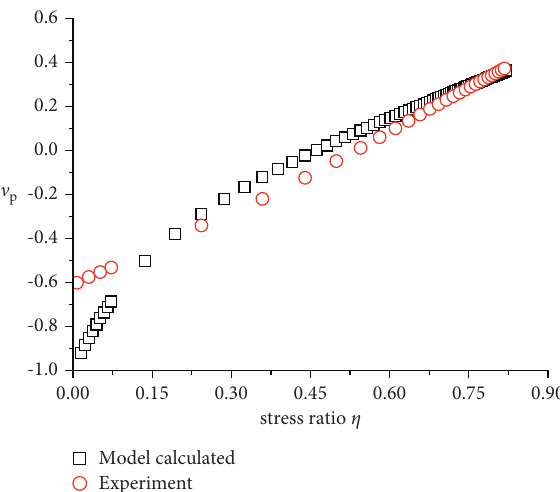
Figure 20: The evolution of v